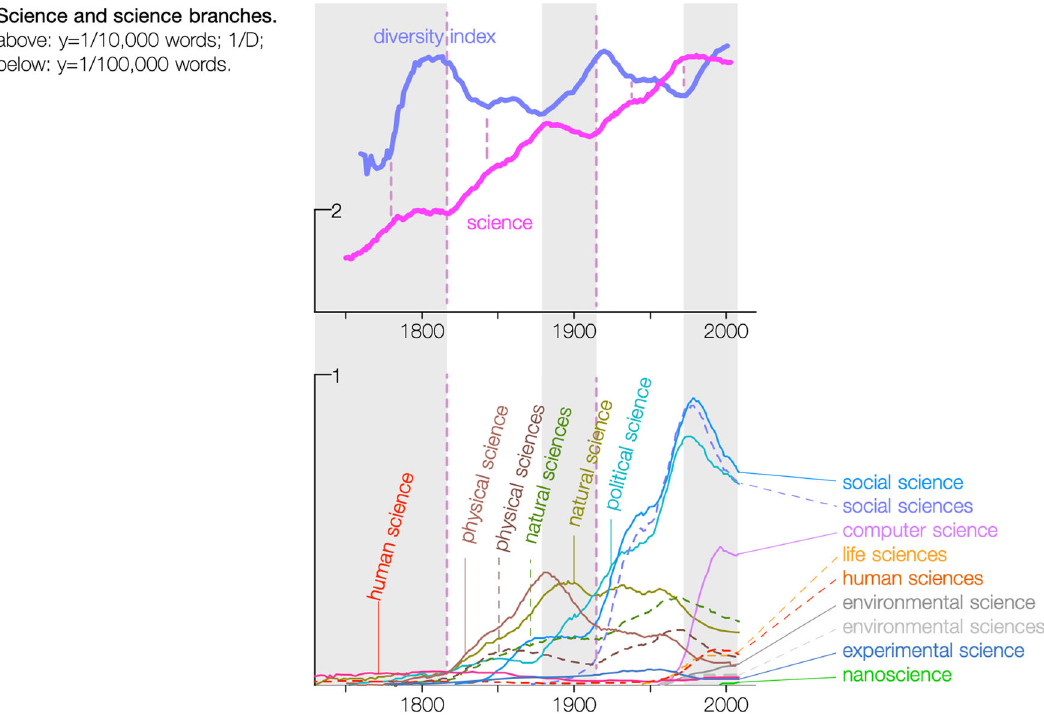
Fig. 5 Cycles of diversi fi cation in science and scienti fi c fi elds. Culture goes through century-long cycles of growth and reform. This phenomenon can be observed for example in “ science ” and different scienti fi c fi elds. The cycles of growth and reform can also be thought of as cycles of diversi fi cation: diversity decays during growth, but it rebounds during reform. Source: Baciu (2020). License: